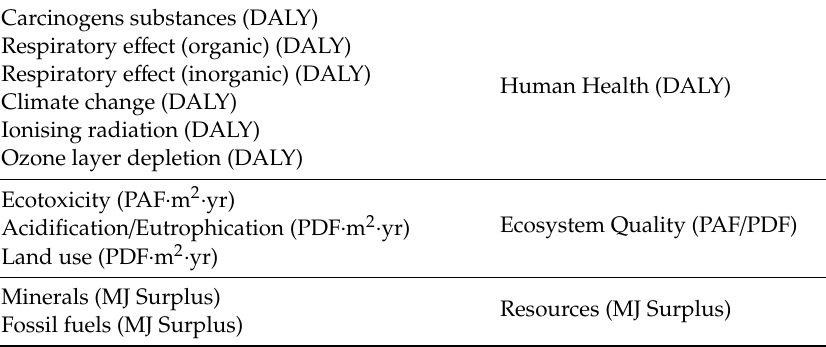
Table 3. Impact and damage categories for Eco-Indicator